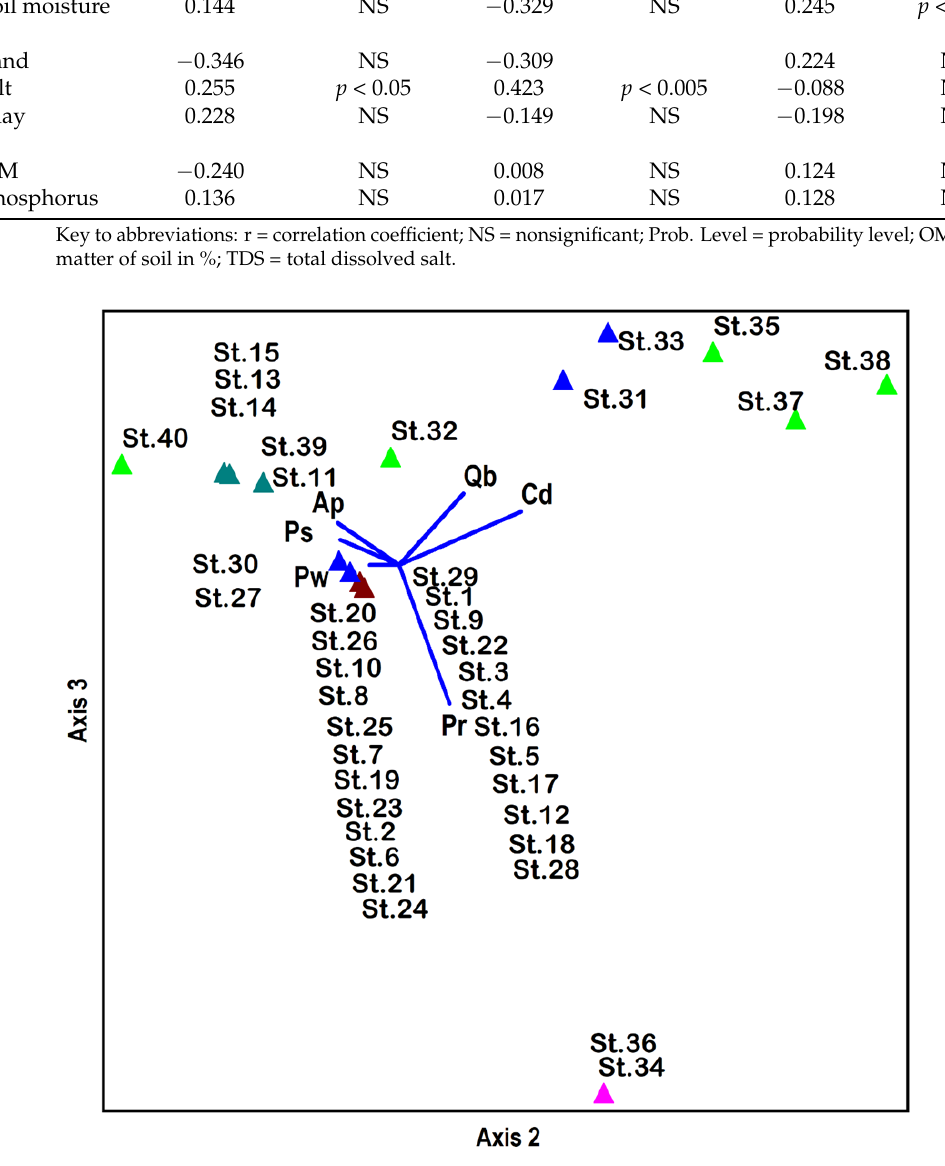
The correlation between the PCA ordination of the three axes with different environ- mental variables are shown in (Table 4). Axis 1 was significantly correlated with elevation ( p < 0.05) and silt ( p < 0.05), while the other environmental factors did not show a signifi- cant correlation. Axis 2 ordination showed a significant correlation ( p <0.005) with silt, whereas no correlation was observed with the other environmental factors. Ordination on axis 3 was a highly significant correlation ( p <0.001) on the elevation and a significant cor- relation between the maximum water-holding capacity and soil moisture, while the other environmental variables did not show a significant correlation. 3.5. Understory Vegetation Data Ward’s Cluster Analysis of Stands Based on fre quency, Ward’s cluster dendrogram distributed the understory vegeta- tion into four groups (Figure 4). Table 5 lists the average frequency of these four groups, while Table 6 presents their environmental factors.